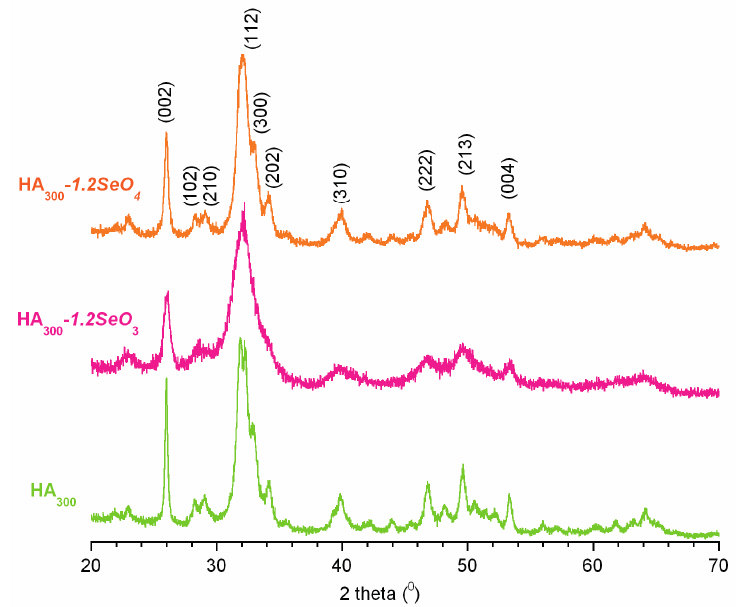
Figure 1. PXRD patterns of the analysed samples: HA 300 , HA 300 -1.2SeO 3 and HA 300 -1.2SeO 4